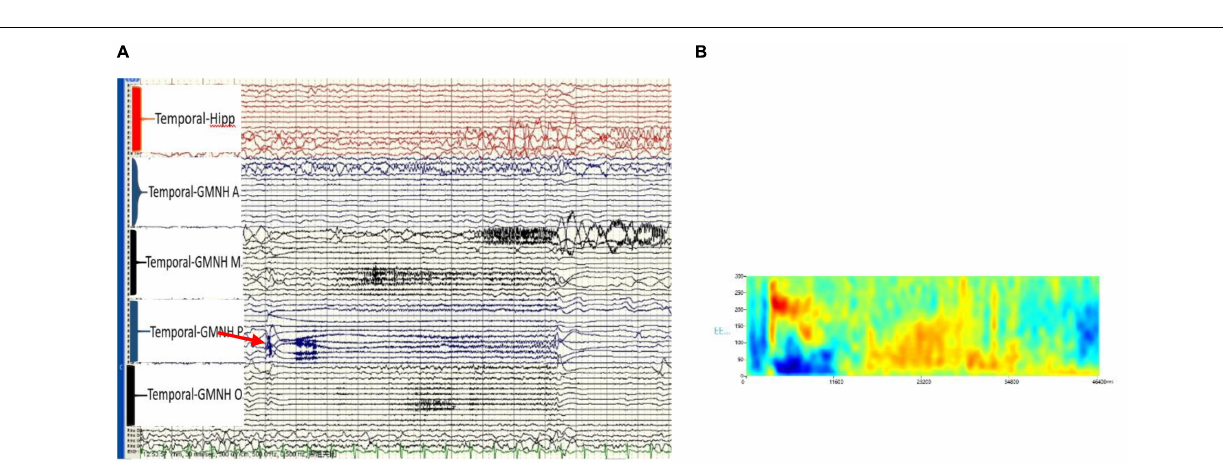
FIGURE 3 | (A) Ictal high-frequency oscillation (HFO) of the stereotactic-electroencephalogram (SEEG), post-GMNH showing HFO (ripple), arrow. (B) Time frequency showing direct current (DC) shift and HFO, maximum at 300 Hz of the initiation discharge of SEEG. Hipp, hippocampus; GMNH A, anterior part of heterotopia; GMNH M, middle part of heterotopia; GMNH P, posterior part of heterotopia; GMNH O, occipital lobe part of